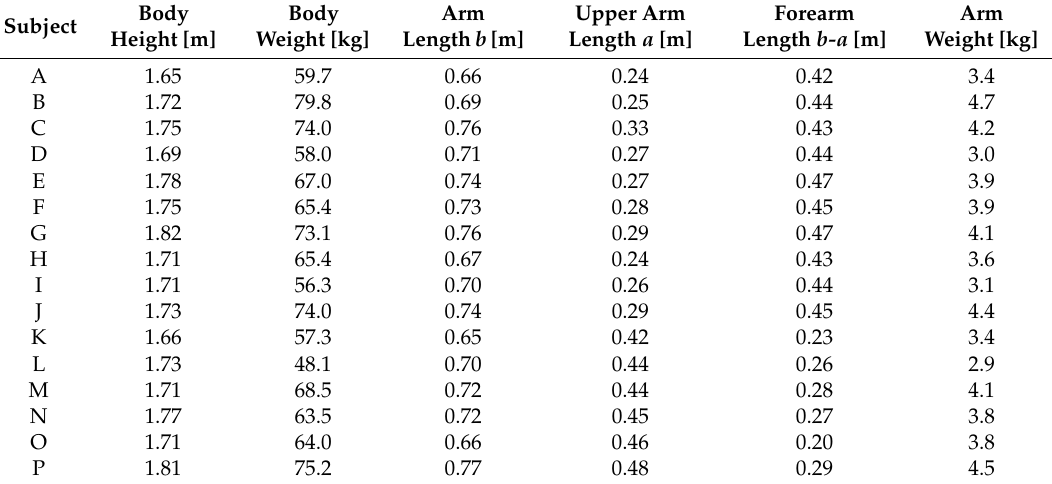
Table 2. Parameter values of the subjects (steering angle feedback reaction force control system).